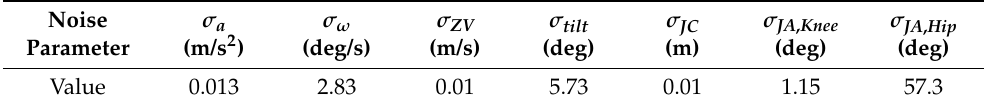
Table 1. IMU and measurement noise values for the ErKF method. The noise values for the ac- celerometer σ a and gyroscope σ ω in the process model. The noise values for the zero-velocity σ ZV , gravitational tilt σ tilt , joint center σ JC , knee joint axis σ JA , Knee , and hip joint axis σ JA , Hip in the measurement